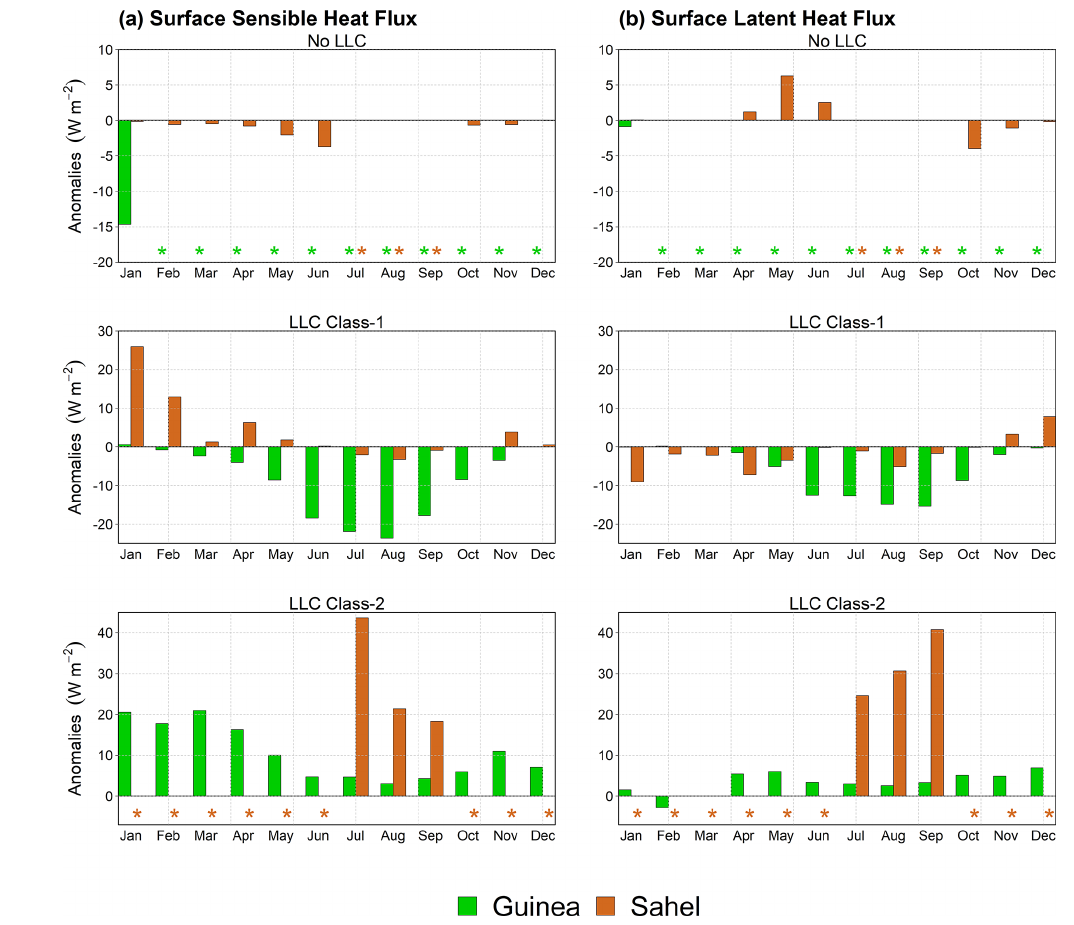
Figure 9. Monthly mean anomalies of (a) surface sensible heat and (b) surface latent heat fluxes computed in the Guinea and Sahel regions for the occurrence of the three LLC classes from 2006 to 2015. The orange and green stars mean that there was no occurrence of the particular LLC class events in the region during that month; hence the composites were not computed. Only occurrences that last for at least 6 consecutive hours are